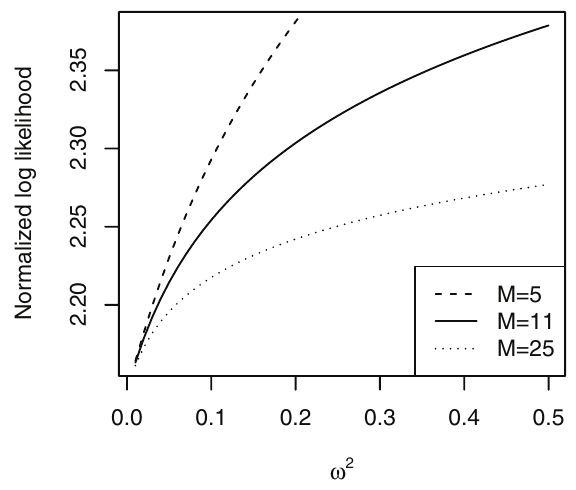
6. Theoretical values of the normalized log-likelihood with σ 2 = 0.5, as a function of ω 2 (interindividual variability), for different values of M (the number of observations per individual).